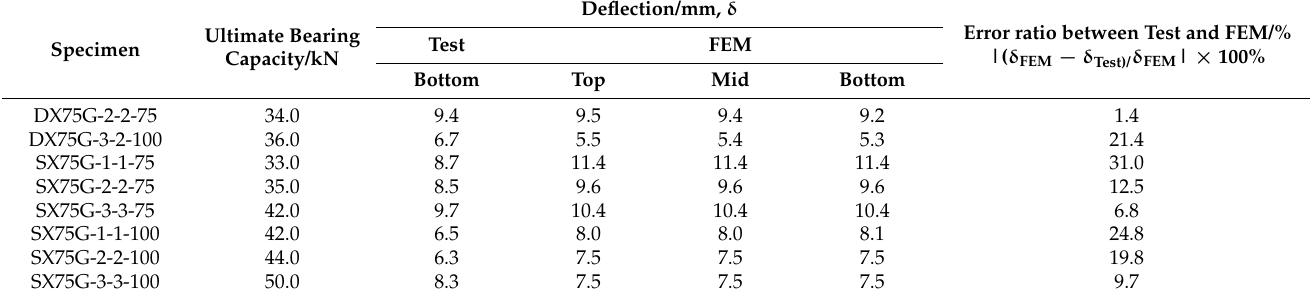
Table 6. The mid deflection under the ultimate bearing capacity.